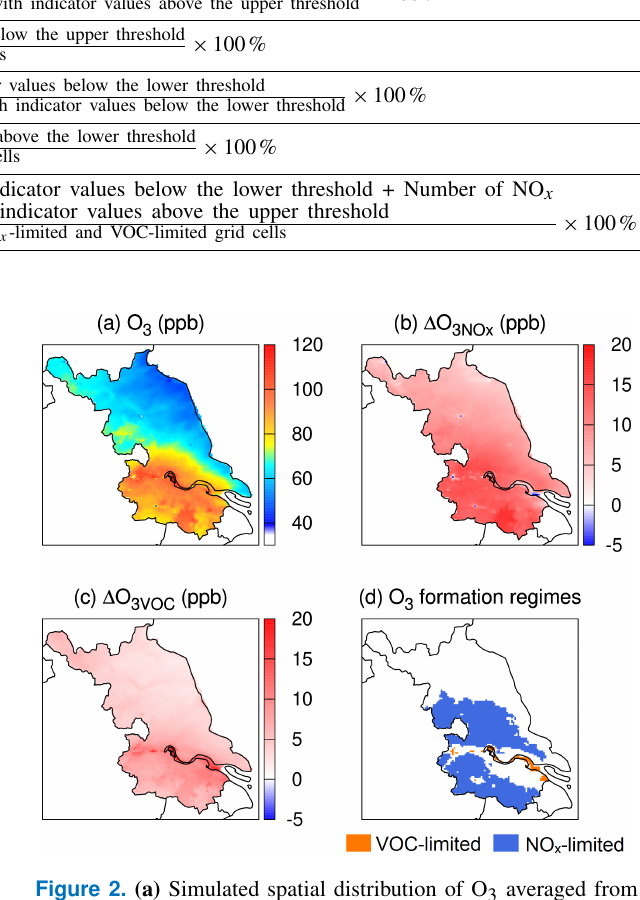
Figure 2. (a) Simulated spatial distribution of O 3 averaged from 13:00 to 16:00LT. during 22–31 July in Jiangsu Province; (b–c) O 3 reduction due to a 35% reduction in domain-wide NO x and VOC emissions, respectively; (d) O 3 formation regimes determined with perturbed